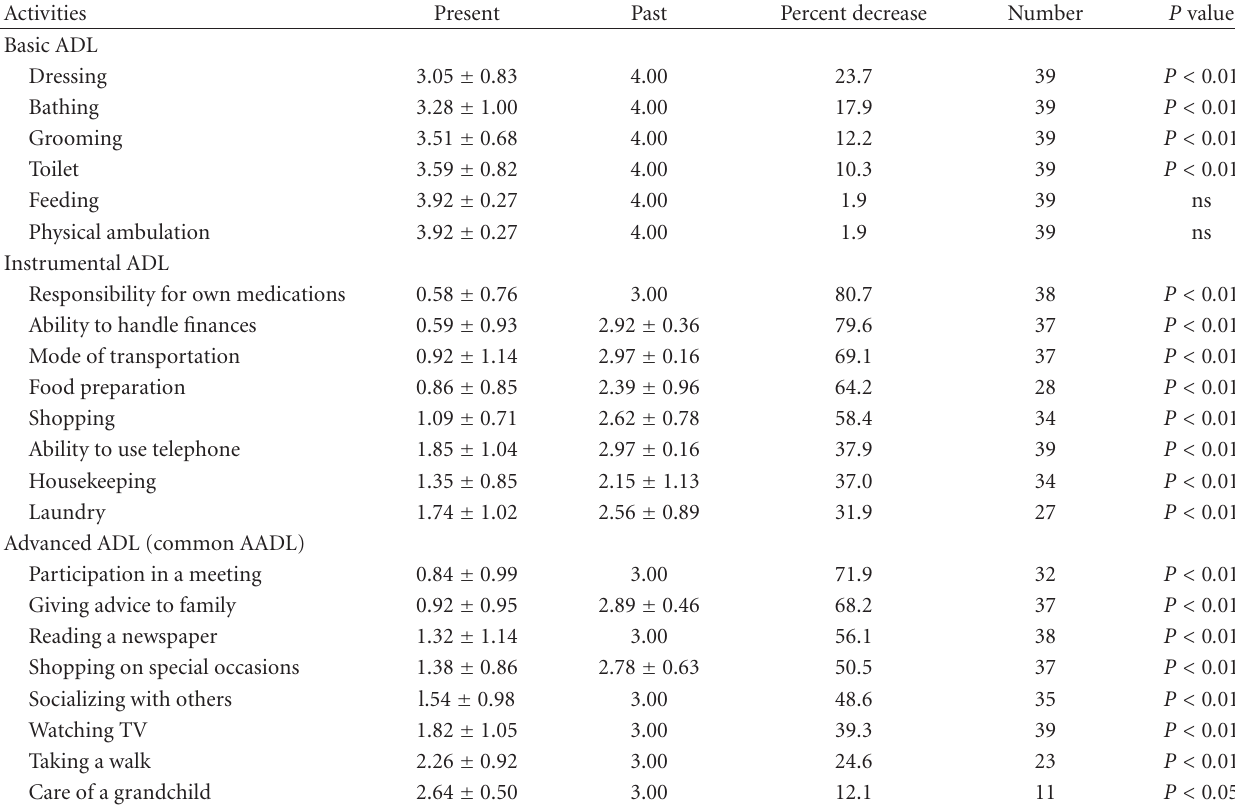
Table 2: Di ff erences in ADL activities of patients; past and present, based on caregiver’s assessment.